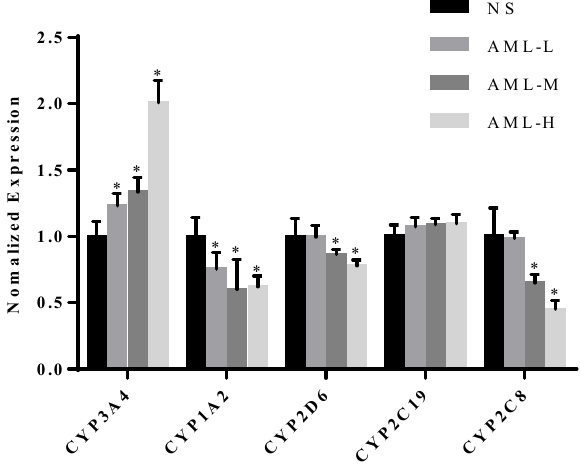
FIGURE 7 – Effect of AML on mRNA expression of CYP3A1, CYP1A2, CYP2D2, CYP2C11 and CYP2C7 in rats (n = 6). *P < 0.05 versus control group.